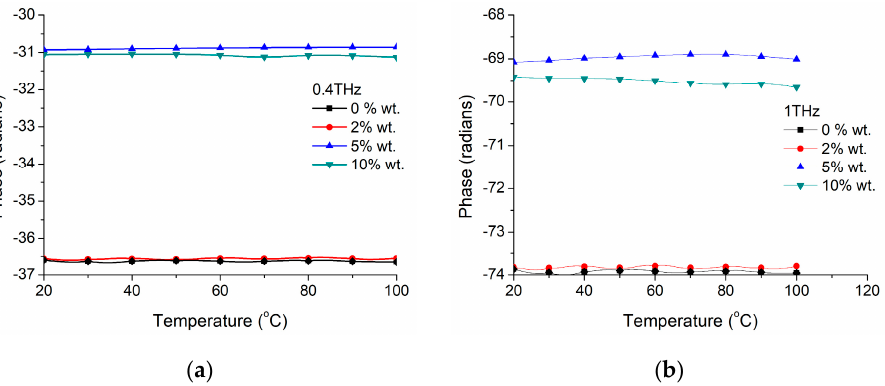
Figure 18. Phase change with temperature in BTO-SBS nanocomposite having different filler concentrations (0% wt, 2% wt, 5% wt, 10%wt.) at different frequencies of: ( a ) 0.4 THz, ( b ) 1 THz.